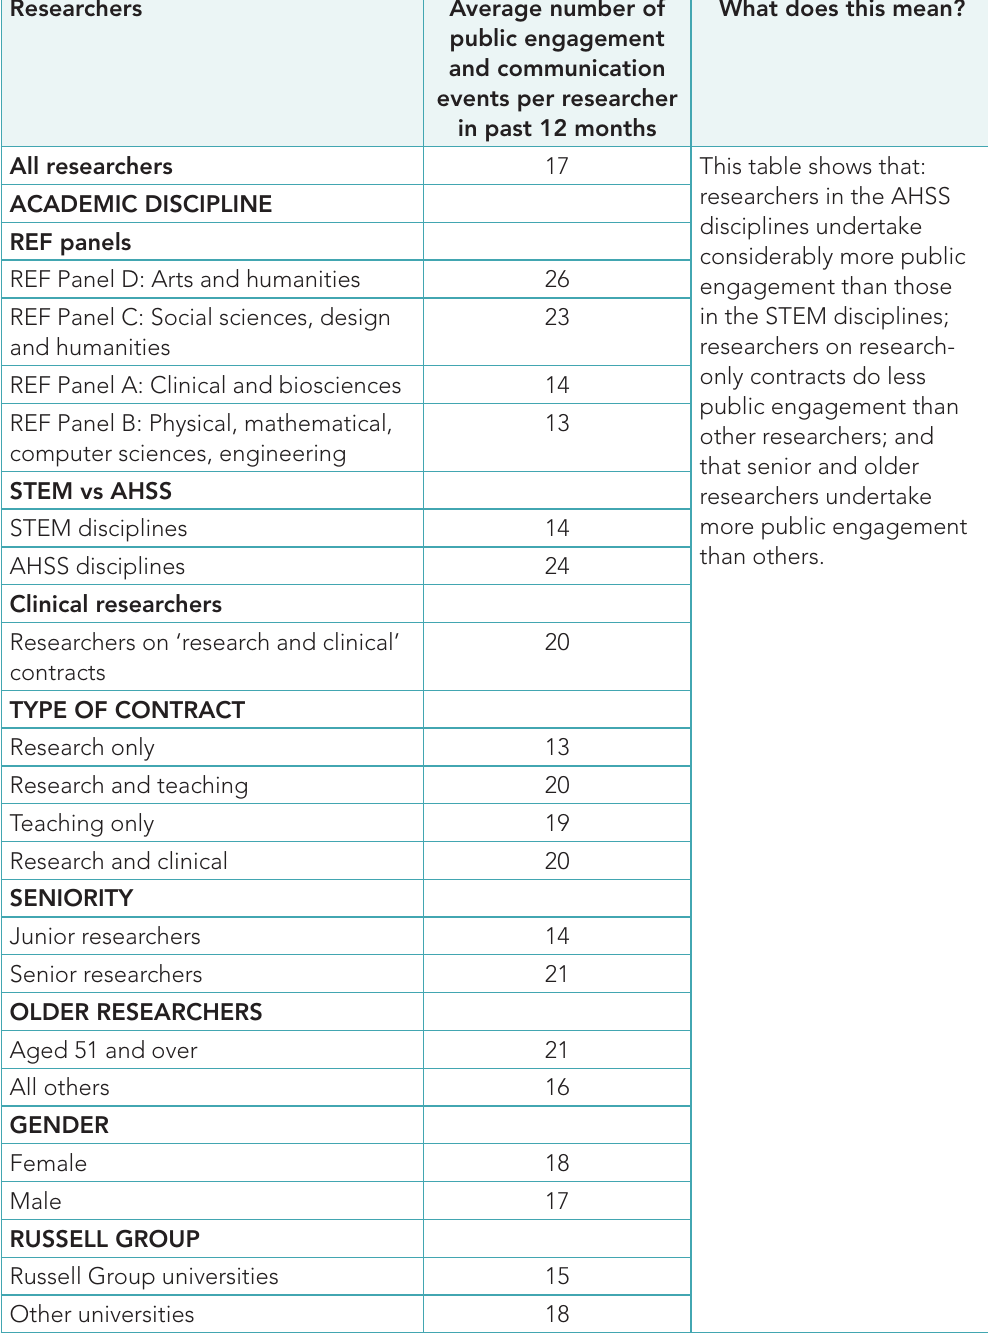
Table 11: Average number of public engagement and communication events